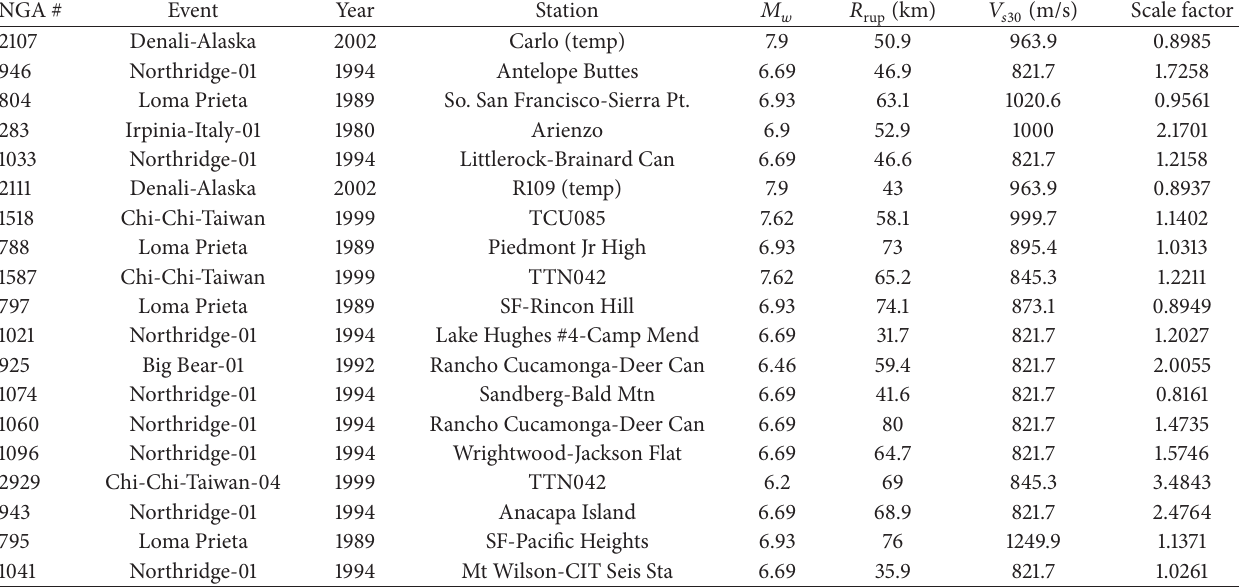
Table 2: Selected ground motion records for site class B.